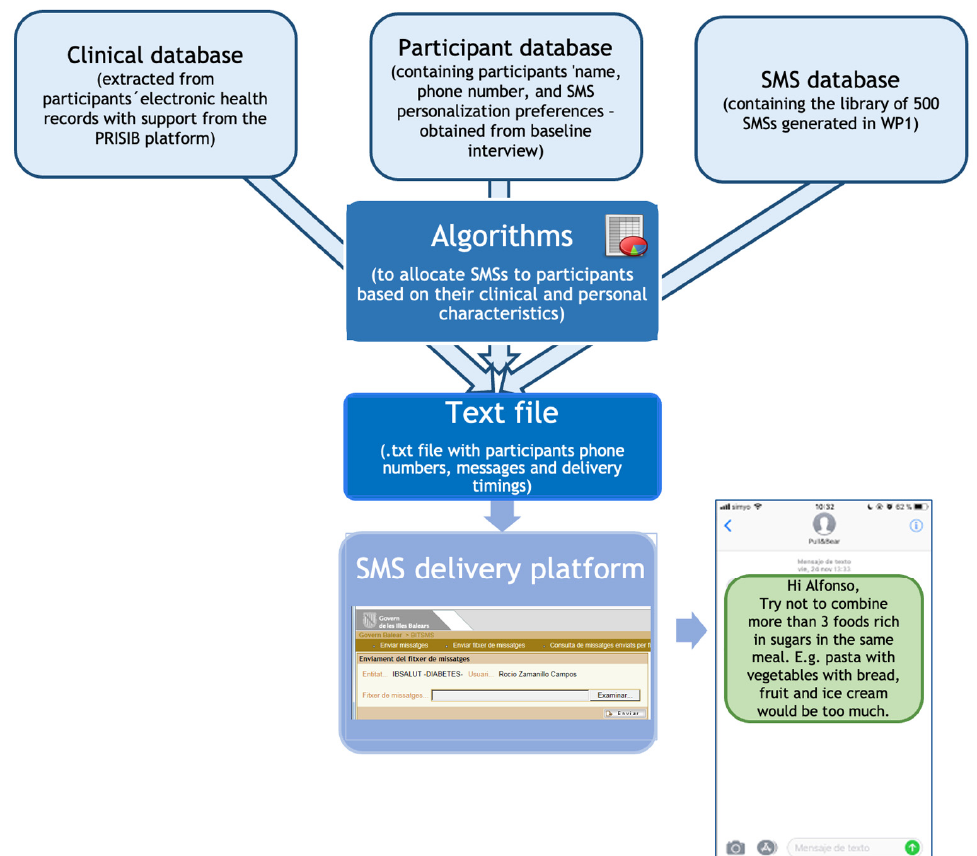
Figure 2. Description of the PreDiabeText Technological System for the messaging intervention. Three databases are combined using specific algorithms in order to produce a text file containing the information to be uploaded to the SMS delivery platform, which will send personalized SMSs to the study participants.